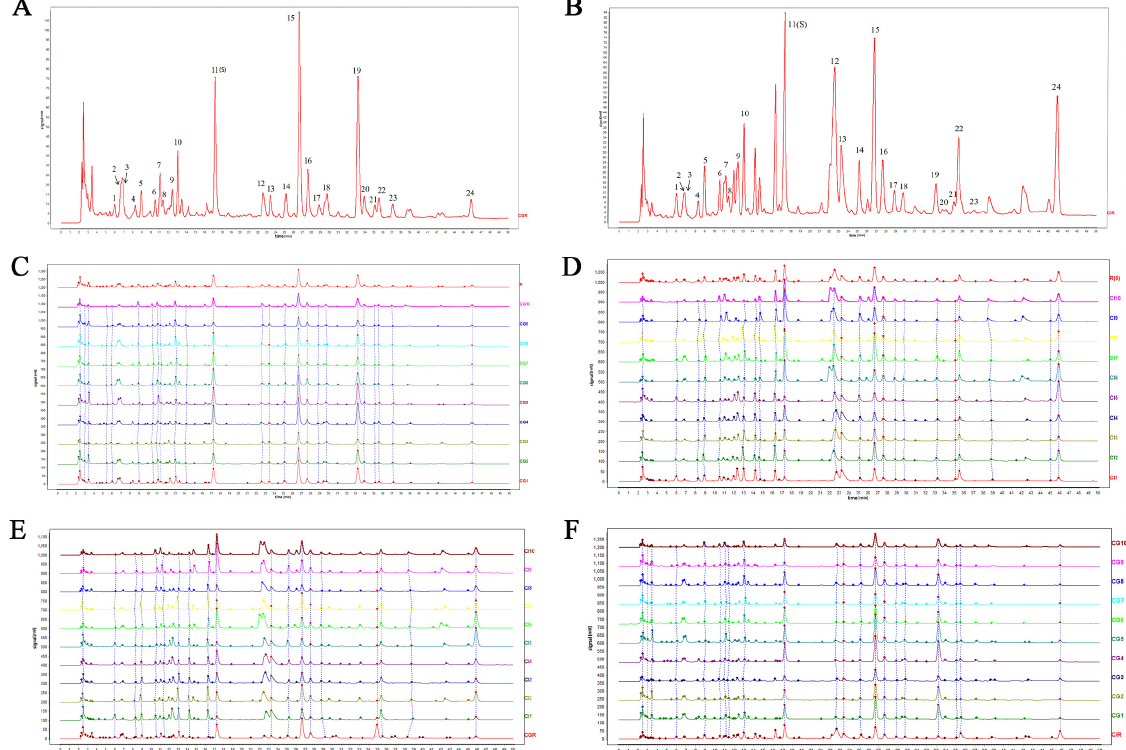
Figure 1. HPLC fingerprints of CG and CI. ( A ) CG reference fingerprint chromatogram (CGR) and 24 common peaks; ( B ) CI reference fingerprint chromatogram (CIR); ( C ) HPLC fingerprints of CG; ( D ) HPLC fingerprints of CI; ( E ) HPLC fingerprints of CI compared to CGR; ( F ) HPLC fingerprints of CG compared to CIR. Table 1. Results of similarity evaluation of HPLC fingerprint between Cichorium glandulosum Boiss et. Huet and Cichorium intybus L.